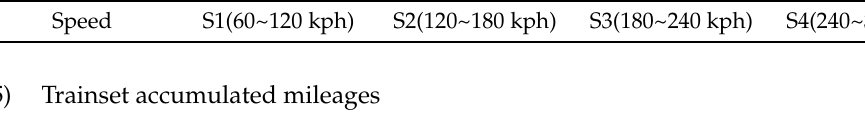
Table 6. Train speed